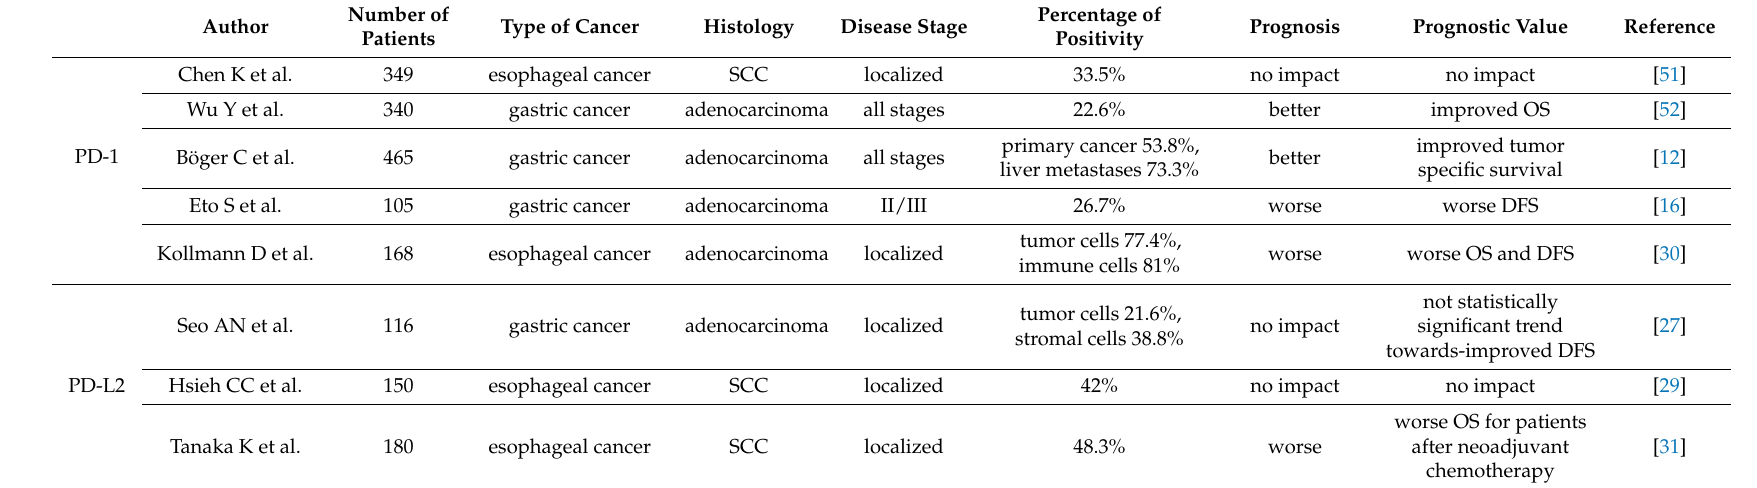
Table 2. Prognostic significance of PD-1/PD-L2 expression in gastric and esophageal